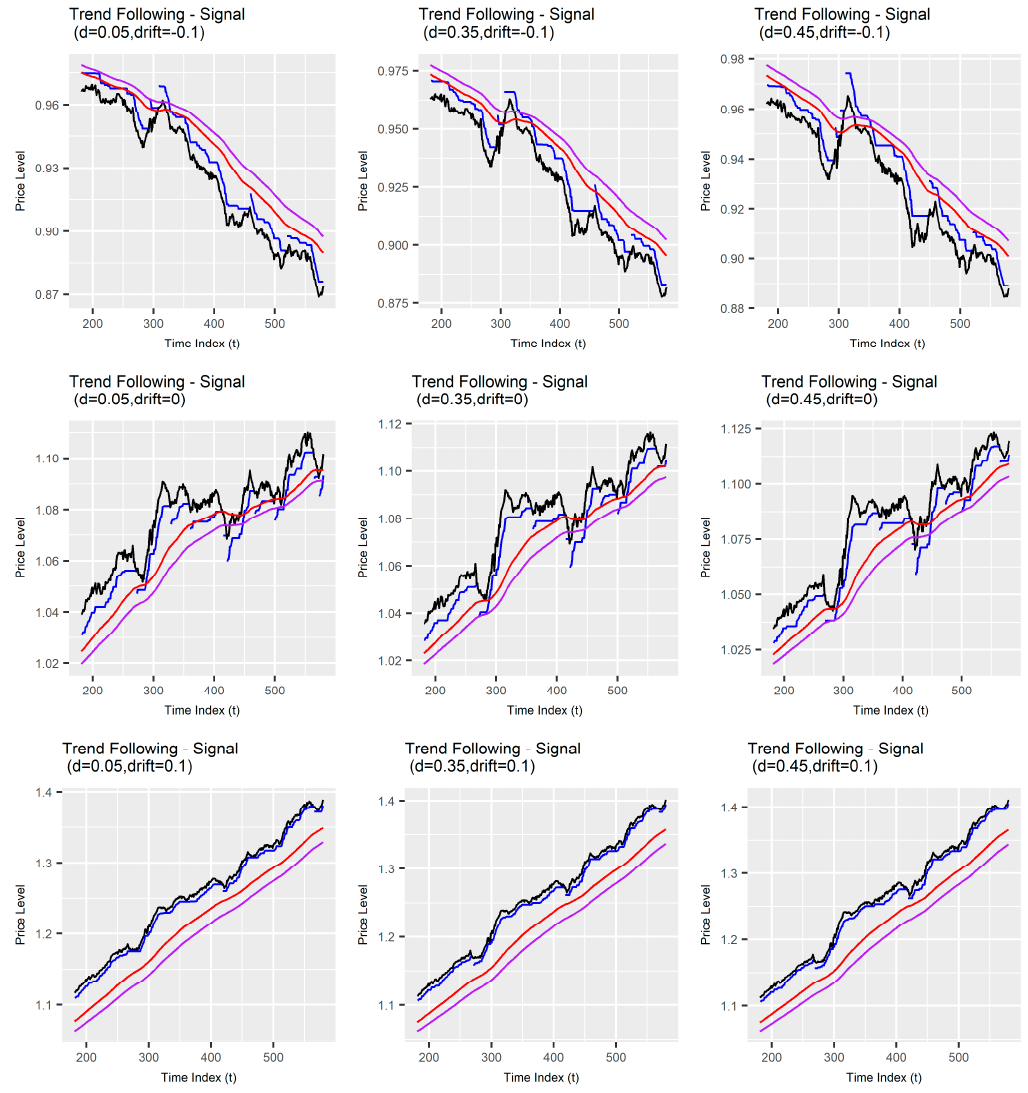
Figure 9. Volatility of price paths .